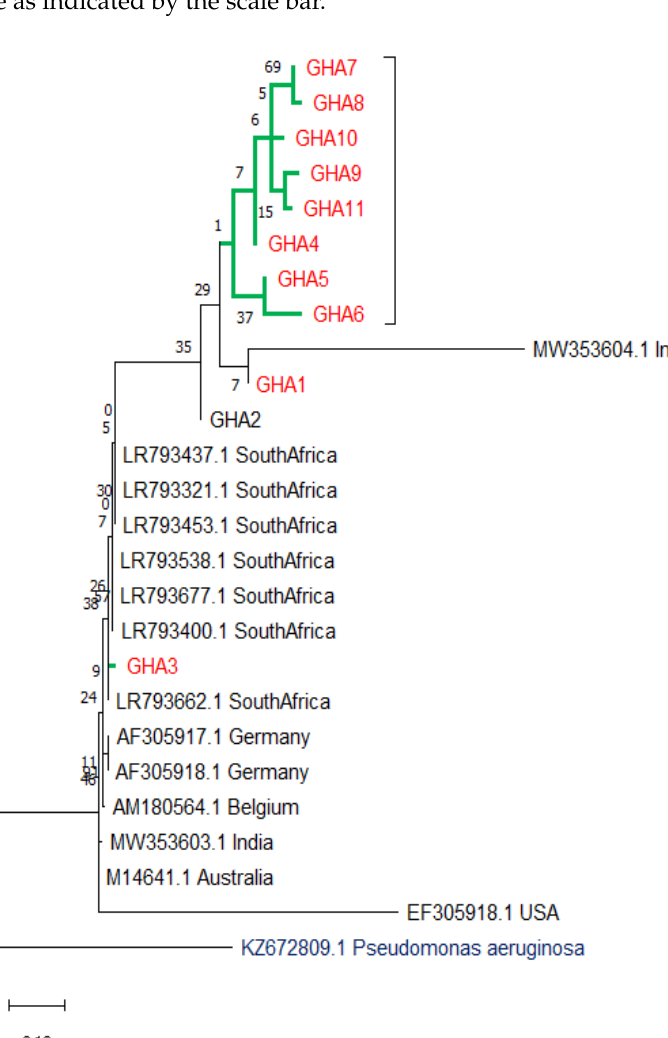
Figure 3. Maximum-likelihood Phylogenetic tree of E. coli based on the sequences of uidA gene sourced from repository of GenBank. Sequences of the present study are denoted GHA1-11 on the tree with Pseudomonas aeruginosa as outgroup.